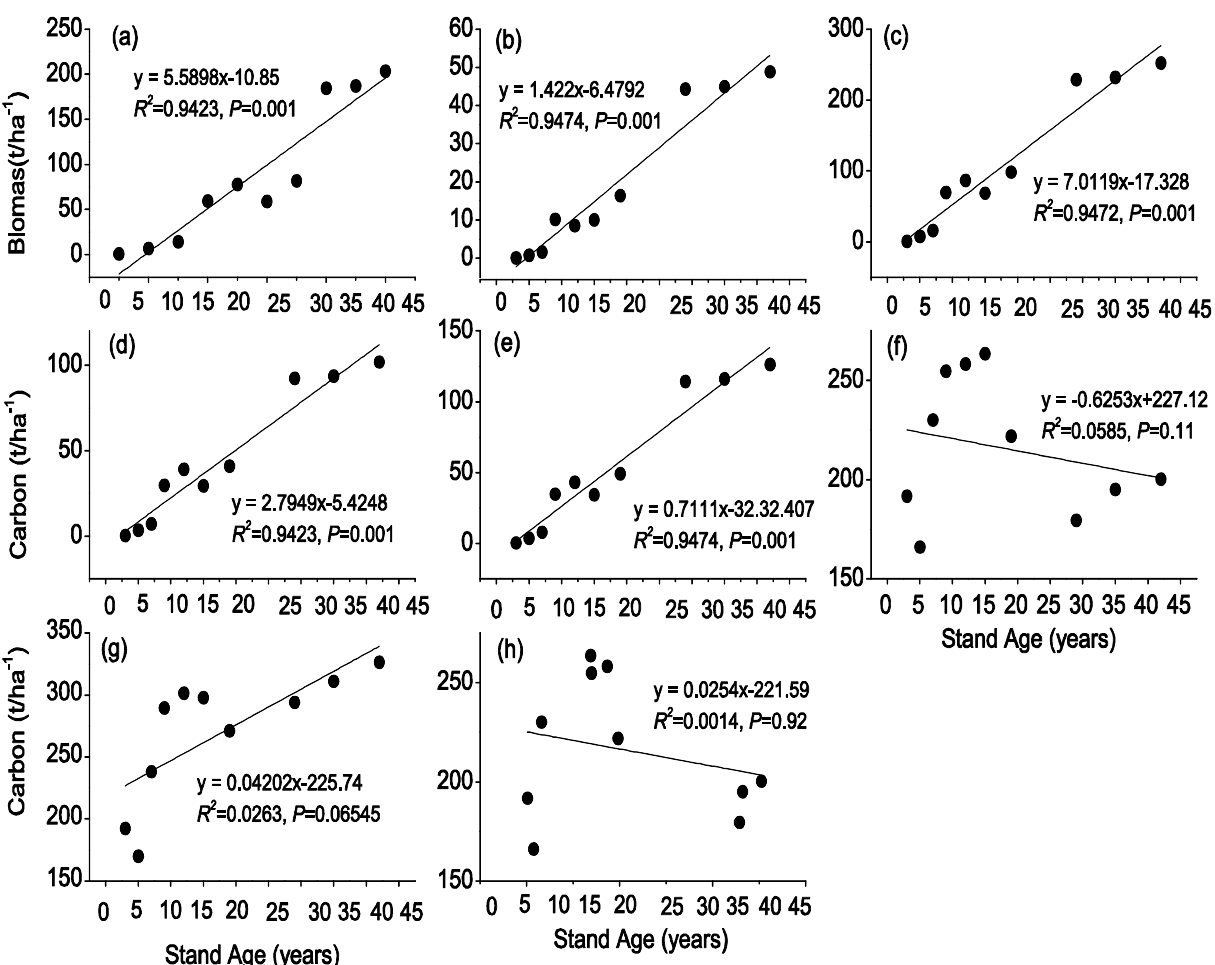
Figure 1. Relationship between biomass C, soil C and stand age. ( a ) Relationship between aboveground biomass and stand age; ( b ) relationship between belowground biomass and stand age; ( c ) relationship between total biomass and stand age; ( d ) relationship between aboveground C and stand age; ( e ) relationship between belowground C and stand age; ( f ) relationship between soil C and stand age; ( g ) relationship between ecosystem C and stand age; ( h ) relationship between plant C and soil